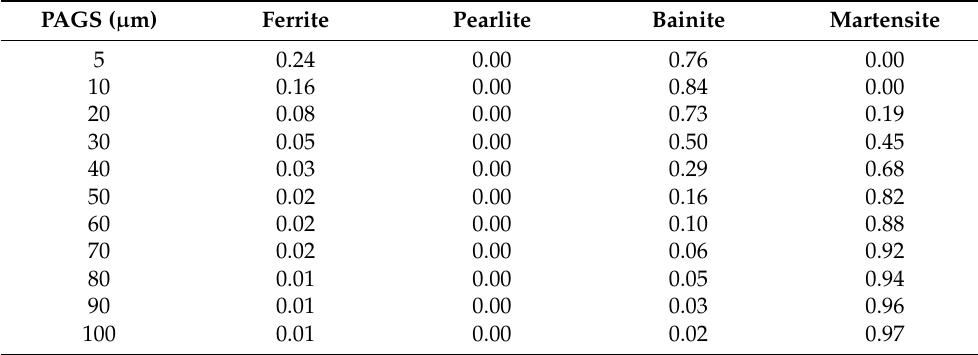
Table 5. Phase fraction according to PAGS when the t 8/5 is 2